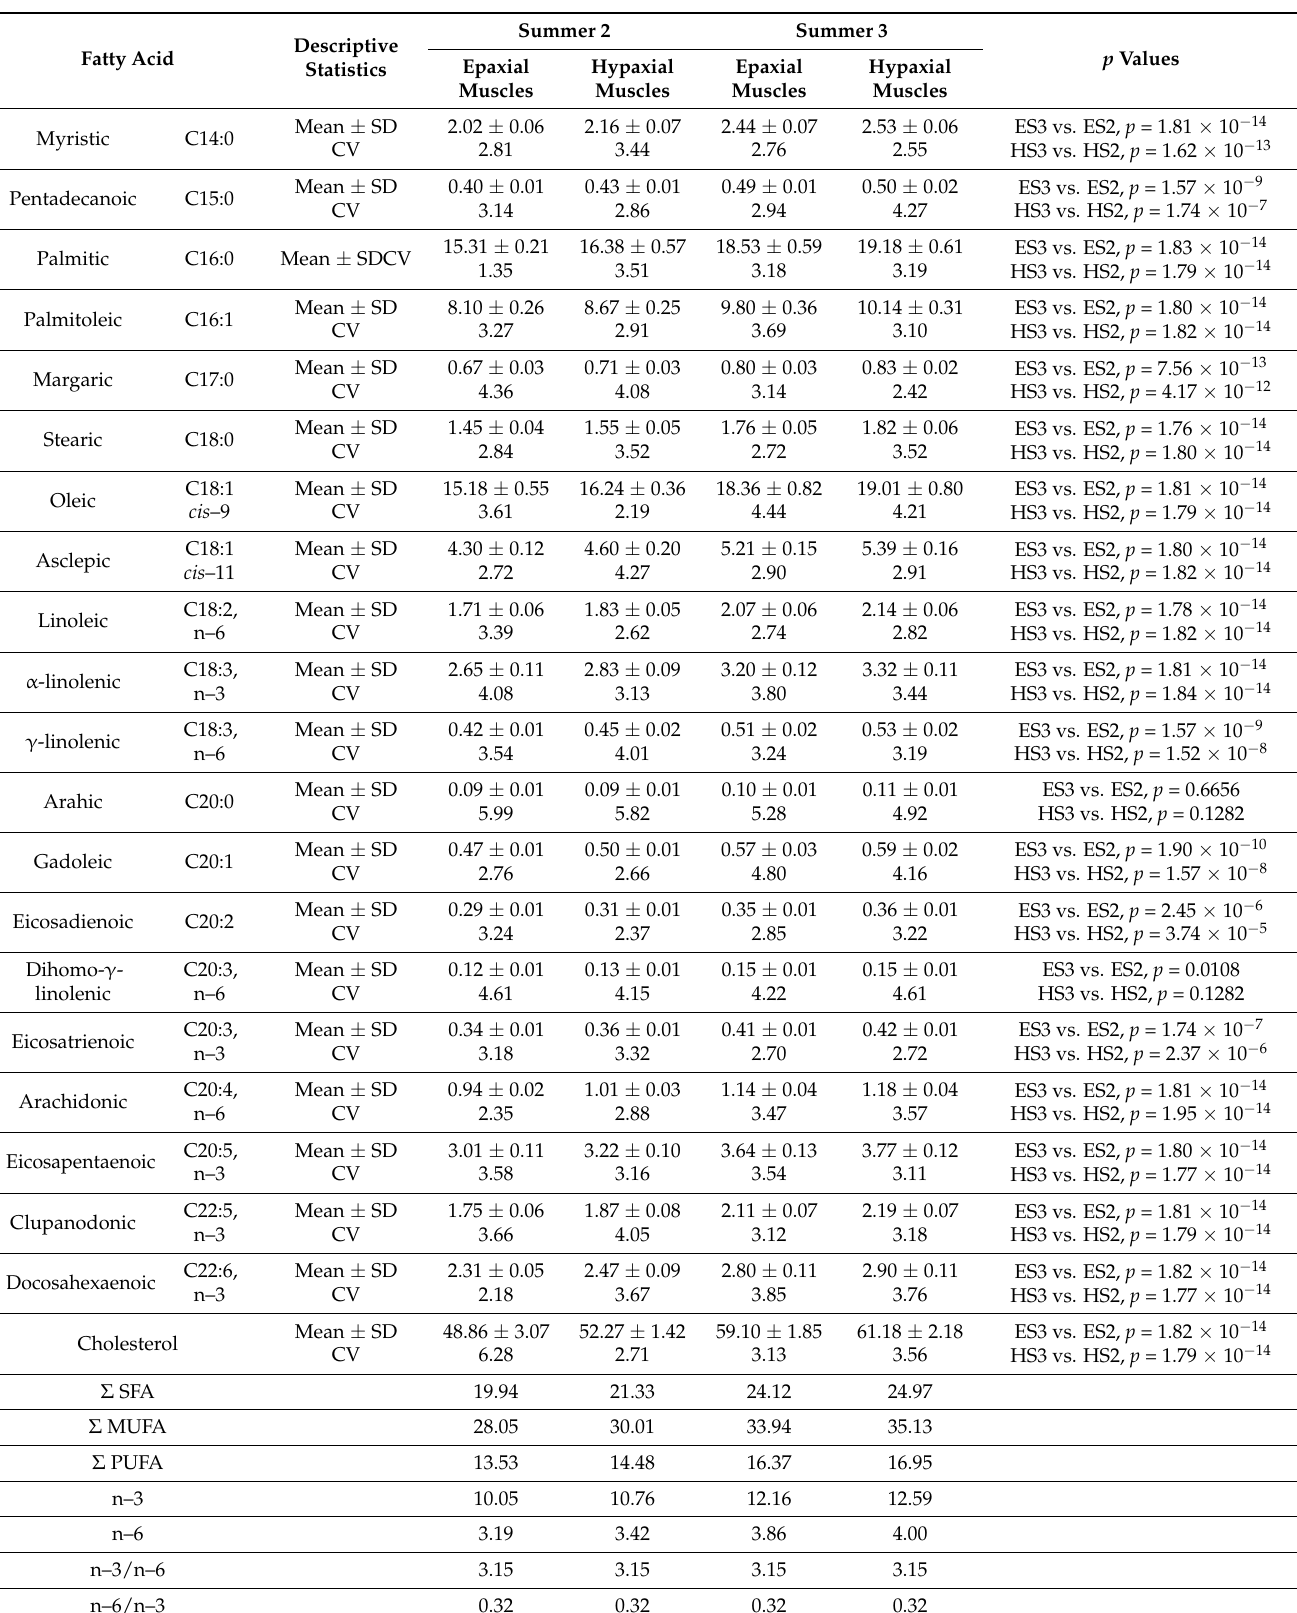
Table 7. Profile of fatty acids (g/100 g total FAME), cholesterol content (mg/100 g) and sanogenic indices of Polyodon spathula sturgeons meat, aged two and three